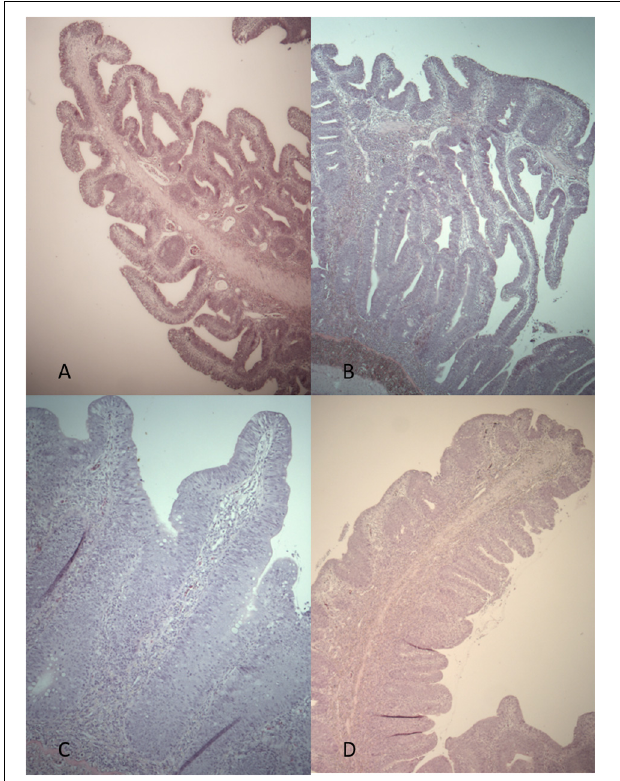
FIGURE 4 | Histological evaluation of intestinal tissues. Hind intestine. Histological sections of hind intestine in FO (A) and ScB (B) fish and in the ScB dietary group with high cell infiltration at two magnifications: Single (C) and complex folds (D) .